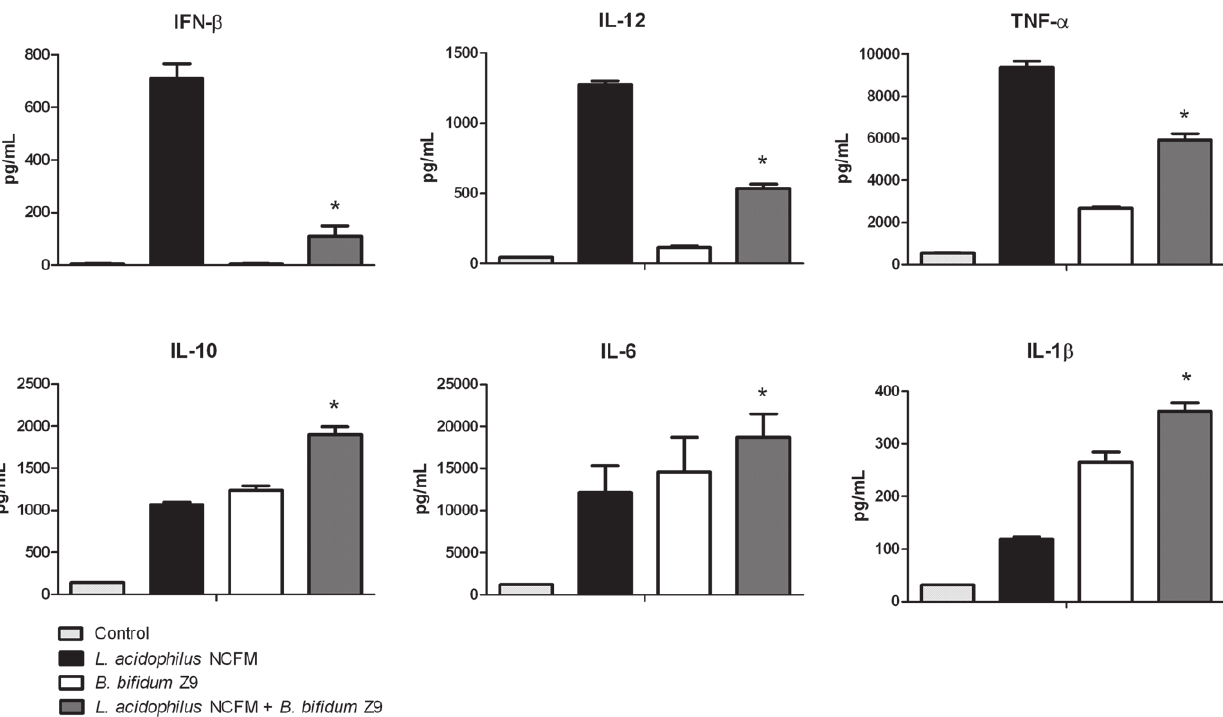
Figure 4. Induction of cytokines in Lactobacillusacidophilus NCFM and Bifidobacteriumbifidum Z9 stimulated dendritic cells. Protein expression of cytokines was measured by ELISA in supernatants from dendritic cells after 20 h of stimulation with L. acidophilus NCFM, B. bifidum Z9, or with both strains in combination. Supernatant from unstimulated DC were used as controls ( L. acidophilus NCFM + B. bifidum Z9 versus L. acidophilus NCFM P , 0.01). Results are representative of 2